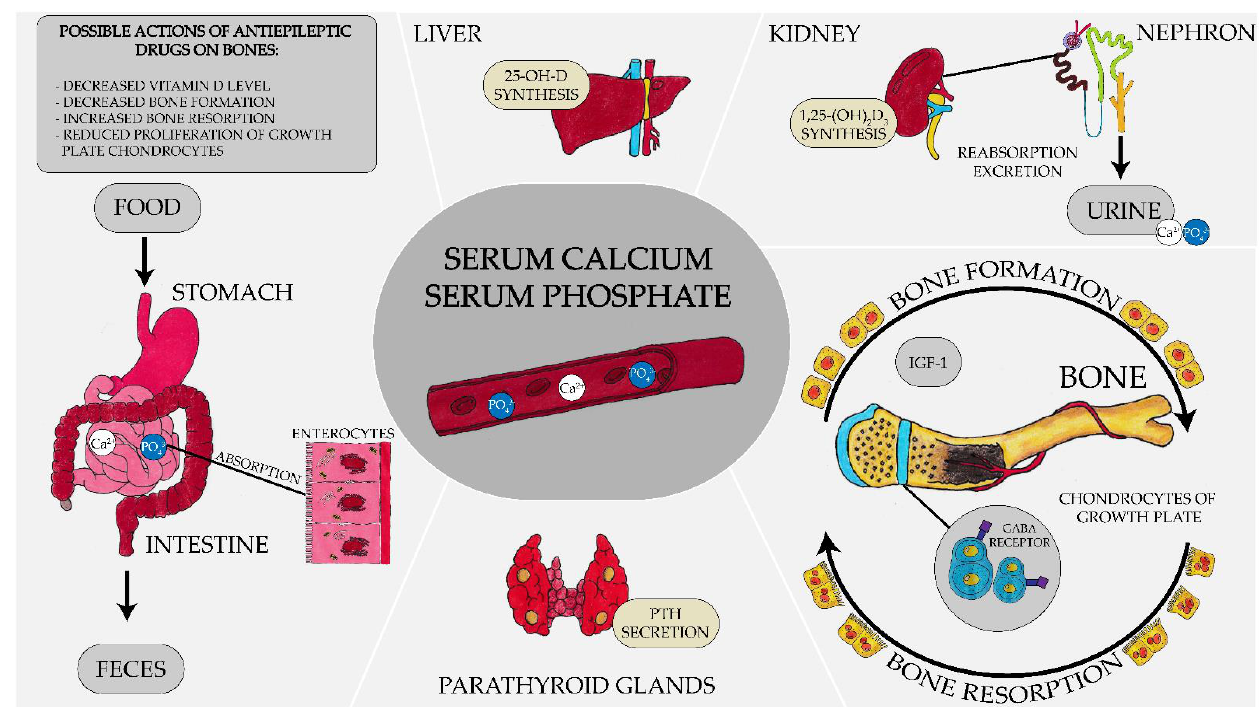
Figure 3. Mechanisms regulating serum calcium and phosphate levels. Serum calcium (Ca 2+ ) and phosphates (PO 43− ) levels depend on intestinal absorption, kidney excretion and release/deposition in bones. Parathormone (PTH) and 1,25-dihydroxyvitamin D 3 are the most important factors regulating Ca 2+ and PO 43− serum levels. Vitamin D increases intestinal Ca 2+ and PO 43− absorption. PTH acts similarly, but its action is indirect by increasing 1,25-dihydroxyvitamin D 3 production. Both 25-hydroxyvitamin D and 1,25-dihydroxyvitamin D 3 increase Ca 2+ and PO 43− reabsorption in the kidneys, whereas PTH increases reabsorption of calcium but increases kidney excretion of phosphates. In bones, the effect of PTH depends on the dose/concentration. In high doses, it causes Ca 2+ and PO 43− reabsorption from bones and low doses it may increase the formation of bones. Similarly, the dual action of 1,25-dihydroxyvitamin D 3 on Ca 2+ and PO 43− reabsorption has been described. Vitamin D acts on the parathyroid gland and regulates PTH secretion. Summing up, the net effect of PTH action is increased calcium with decreased phosphates in the serum and the net effect of vitamin D is increased calcium and phosphates in serum.